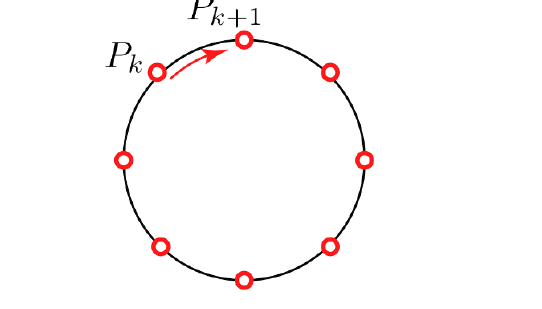
Figure 5 . The geometry is more complicated for N > 2 case than the N = 2 case in (cid:12)gure 4. However, the idea is the same: the classical moduli space CP N (cid:0) 1 is lifted by twisted boundary condition along S 1 into N di(cid:11)erent points P 1 ; : : : P N , however tunneling between di(cid:11)erent these C points, as given by fractional instantons, lifts the N -fold degeneracy, restoring the center symmetry